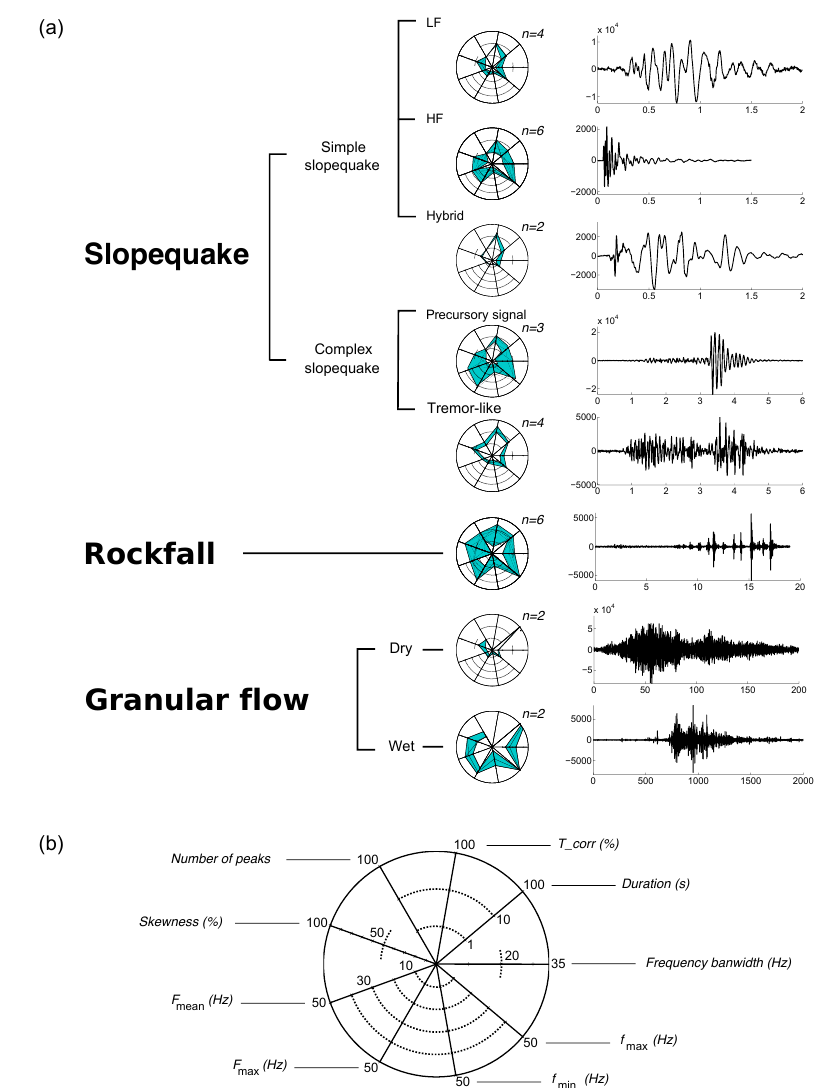
Figure 11. (a) Summary of the proposed classification with plots of the attributes for the examples presented in the precedent figures and an example waveform for each class. The convention for the attribute plot is presented in (b) ; n being the number of seismic signals examples used to plot the feature